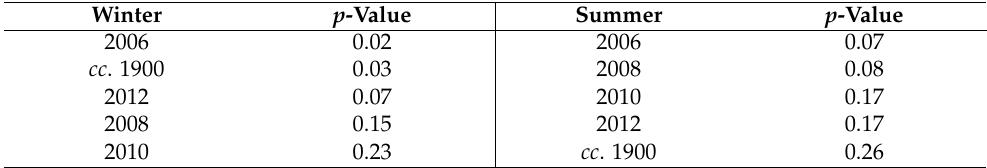
Table 5. Sample sites sorted in ascending order of the relationship between infiltration difference between 10 cm and 200 cm for winter and